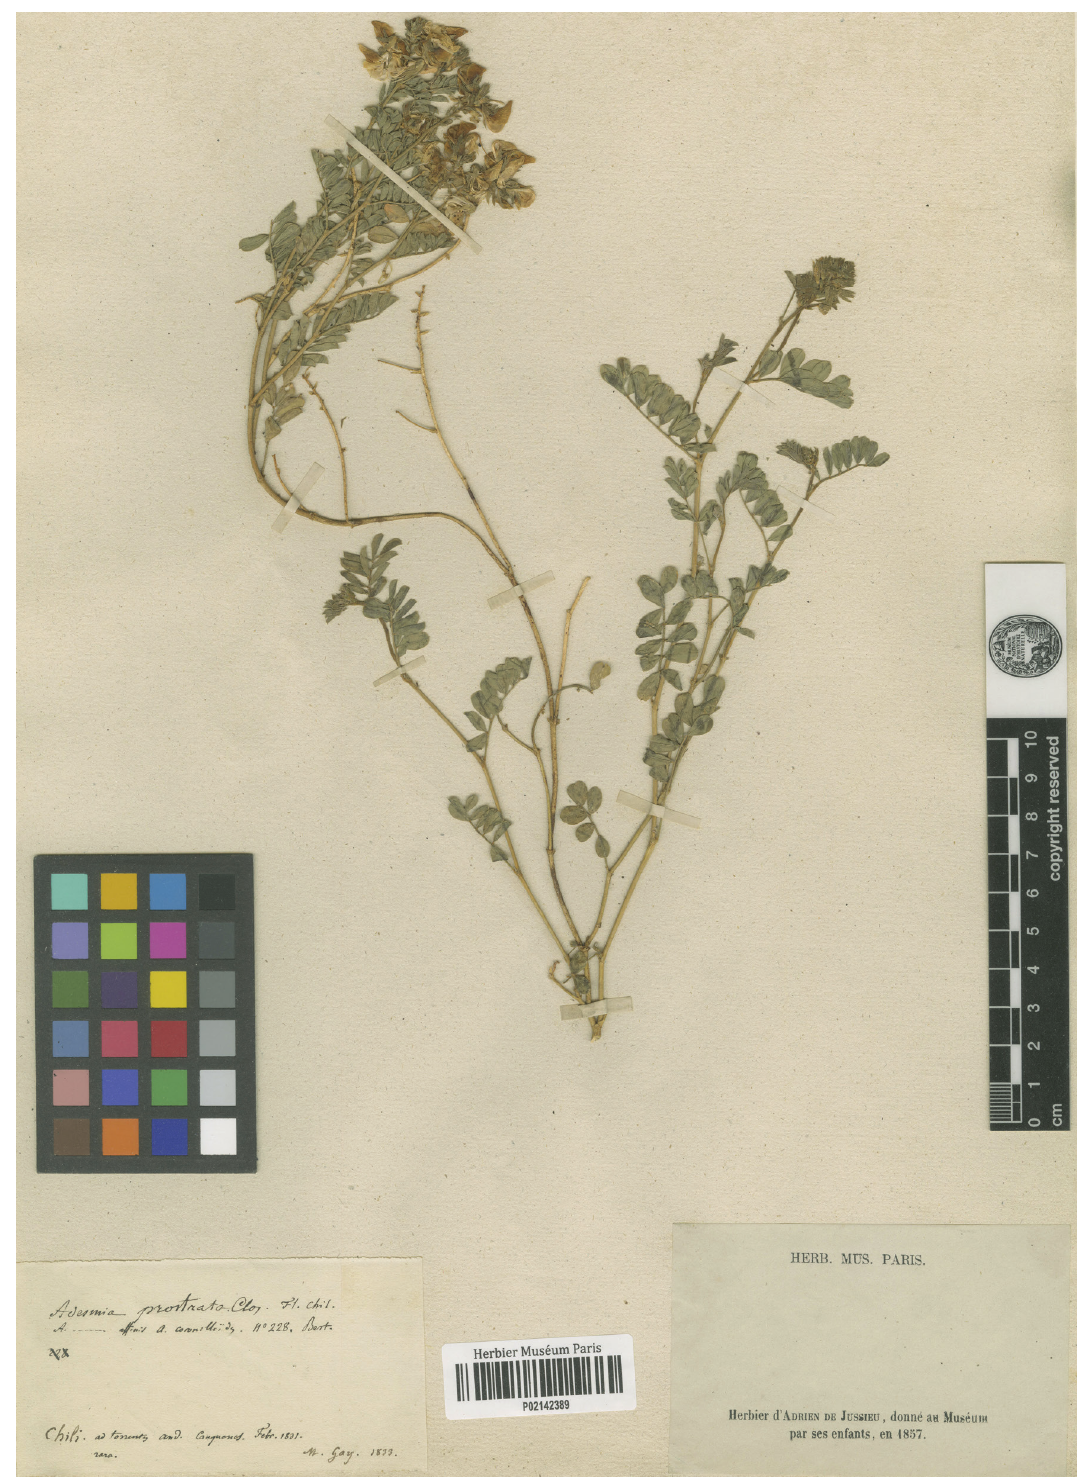
Figure 1: Adesmia prostrata , collected by Gay in Cauquenes, Herbier d’Adrien de Jussieu, Muséum d’Histoire naturelle